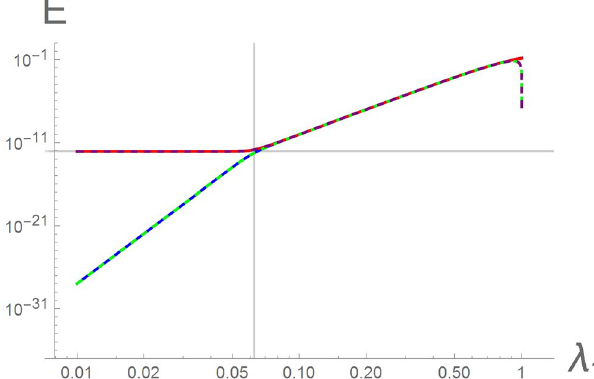
Figure 4. Energy eigenvalues  of the two lowest-lying excited states of the symmetric Ising-Kitaev chain 1,2 (1)–(2) in the piece-wise uniform applied field (3) as a function of λ 1 = λ 3 with λ 2 = 4 for N 1 = N 2 = 10 and M = 20. The solid curves represent the result of the exact numerical diagonalization. The dashed lines represent 2 1 , in this particular the analytic solutions to Eqs (34) and (35). The vertical grid line corresponds to λ λ = − N M 12 2 case, λ 1 = 1/16. On the right side of this line the green and purple dashed lines corresponds to the two eigenvalues in Eq. (10). On the left side the green dashed line represents Eq. (9), the purple – Eq. (8). The 20 horizontal grid line corresponds to λ = = − − E 4 M 2